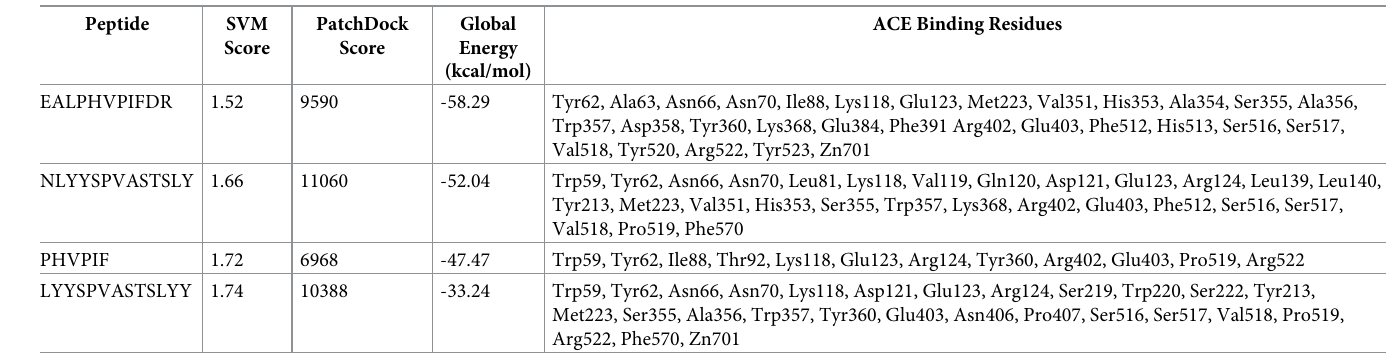
Table 2. Protein-peptide interactions along with docking scores and binding